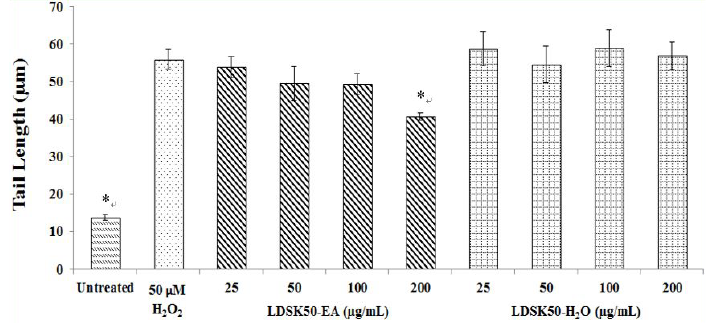
cells treated with H 2 O 2 alone.